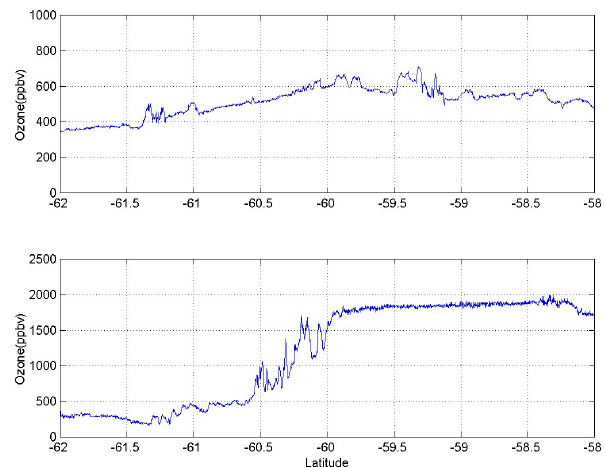
Fig. 5. The concentration of ozone across the region of the polar vortex at above 415K (bottom panel) and below 415K (top panel) potential